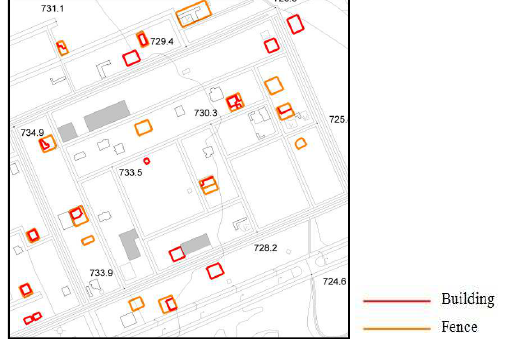
Figure 10. Update of existing geospatial database of